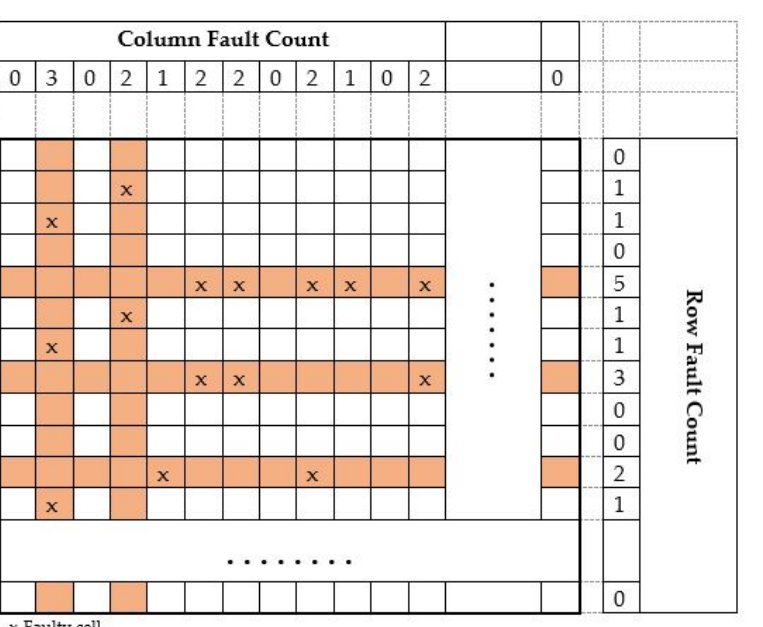
Table 3. Fault test approaches and comparison.